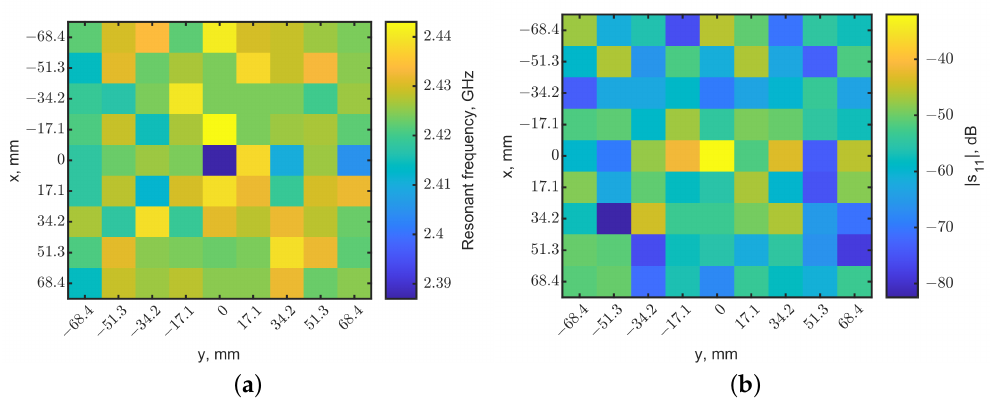
Figure 5. Localization maps generated from the reflection coefficients for the tumor at a depth of 10 mm. The tumor is located at (x = 0, y = 0). ( a ) Map of resonant frequencies, the dark pixel indicates the tumor’s location. ( b ) Map of |s 11 |; the light-yellow pixel indicates the tumor’s location. A raster scan was performed with the same setup without a tumor. The heatmaps of resonant frequencies and reflection-coefficient magnitudes are shown in Figure 7, using the same color scales as Figure 5. Compare Figures 5a and 7a: no dark pixel was in Figure 7a. Similarly, Figure 5b shows clearly the center pixel with a higher reflection coefficient compared to other pixels in Figure 5b and all pixels in Figure 7b.